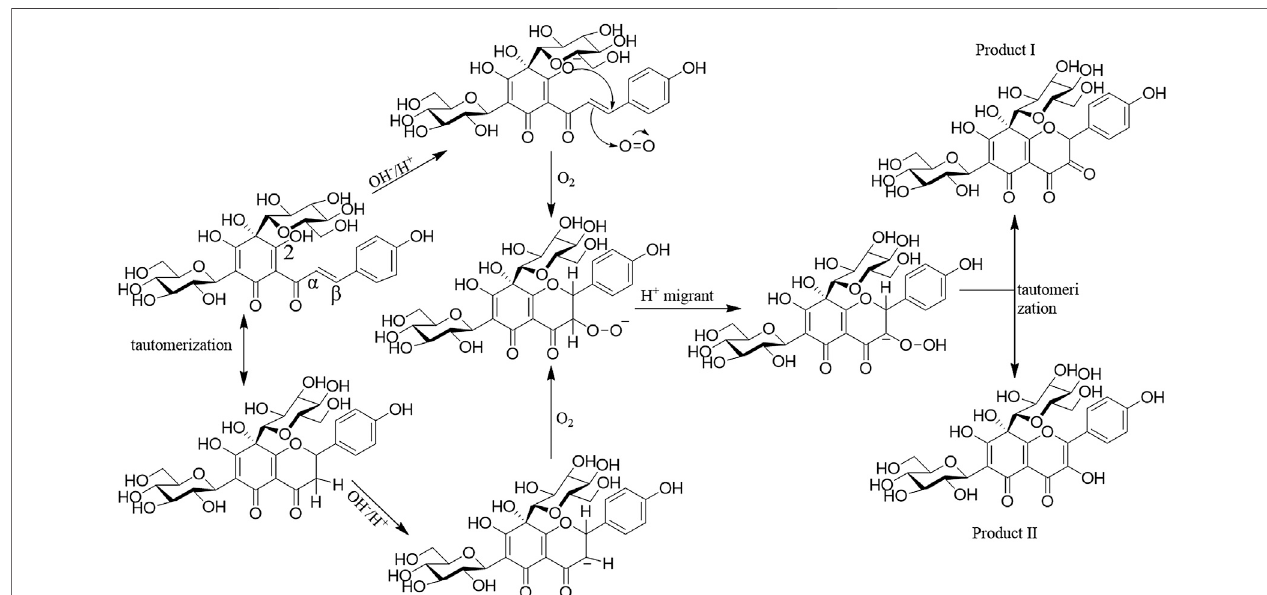
FIGURE 3 | The pathway of HSYA degradation (Pu et al.,